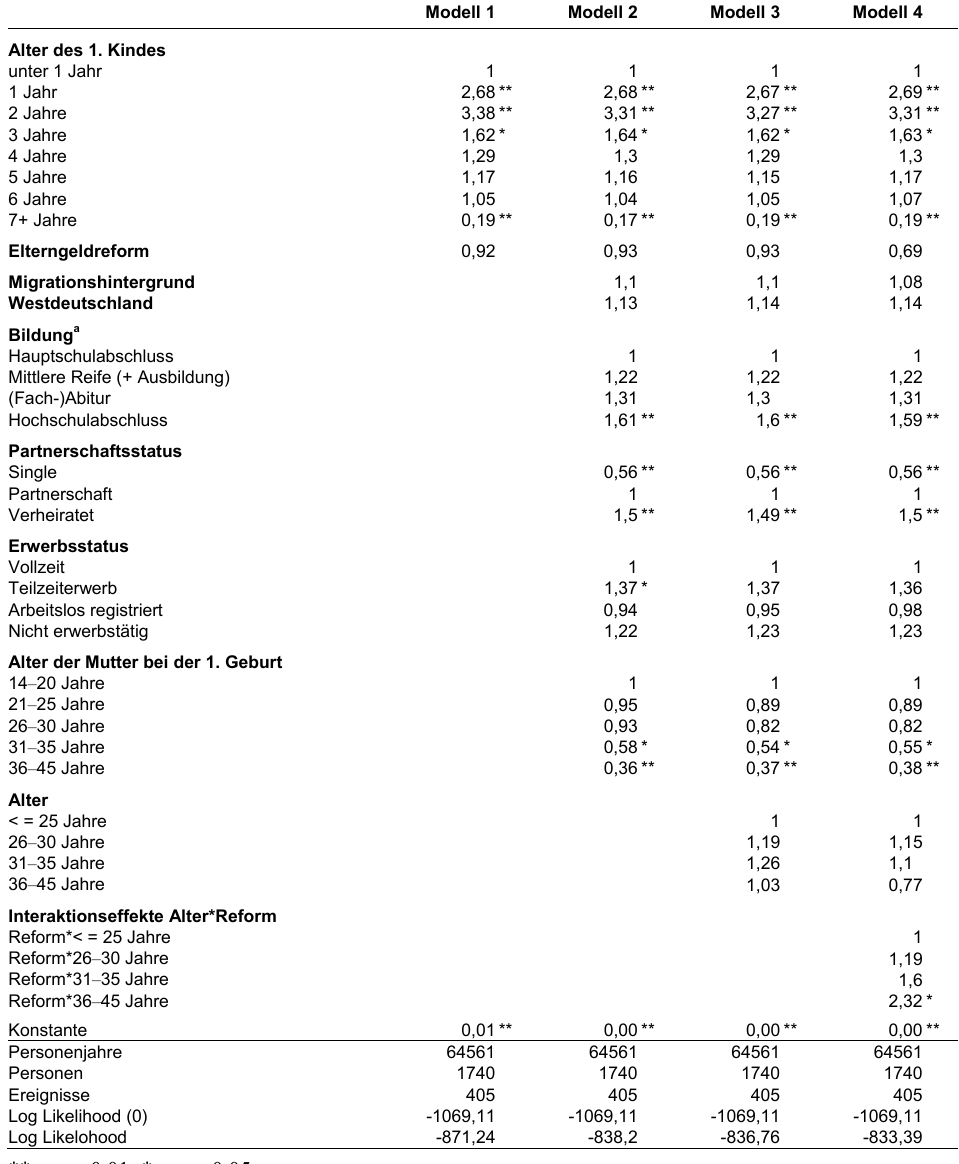
Tabelle 1 : Übergang zum zweiten Kind, Hazard-Ratios (Multivariate